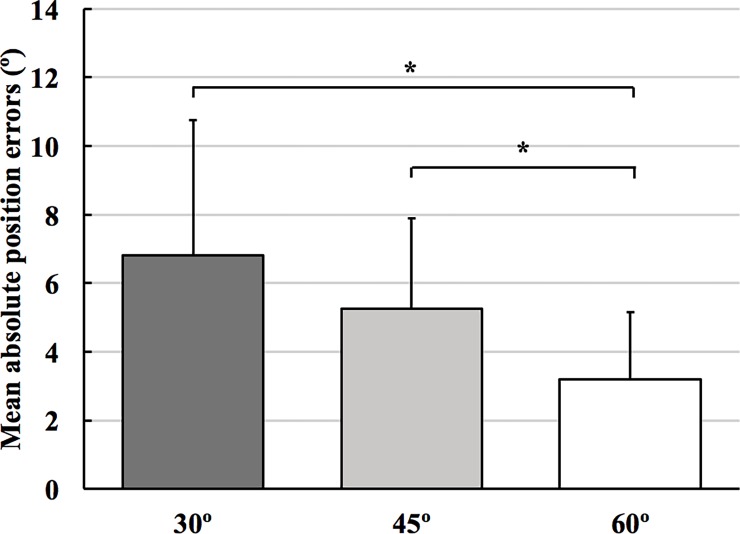
Differences in mean absolute knee joint position error at three target angles.Participants performed a passive knee target matching task with the knee joint more accurately at 60° compared to 30° and 45°. * p < 0.001.